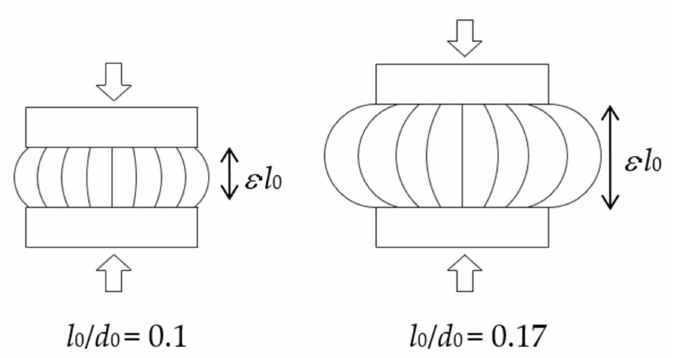
Figure 35. Effect of bulging on deformed geometry of the compressive